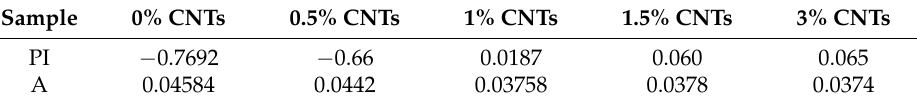
Table 5. Penetration Index for modified and unmodified bitumen.